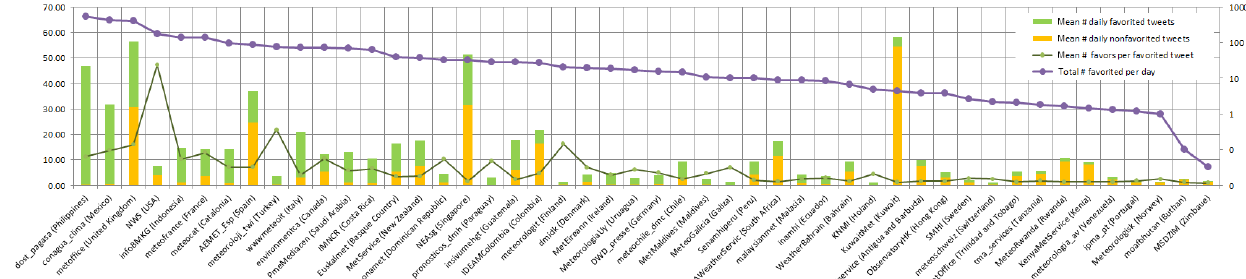
Figure 3. Favorited analysis showing (left) daily averaged values per day during 2016, ratio of favors per favorited tweet and proportion of favorited tweets and (right with logarithmic scale) number (#) of total favorited.